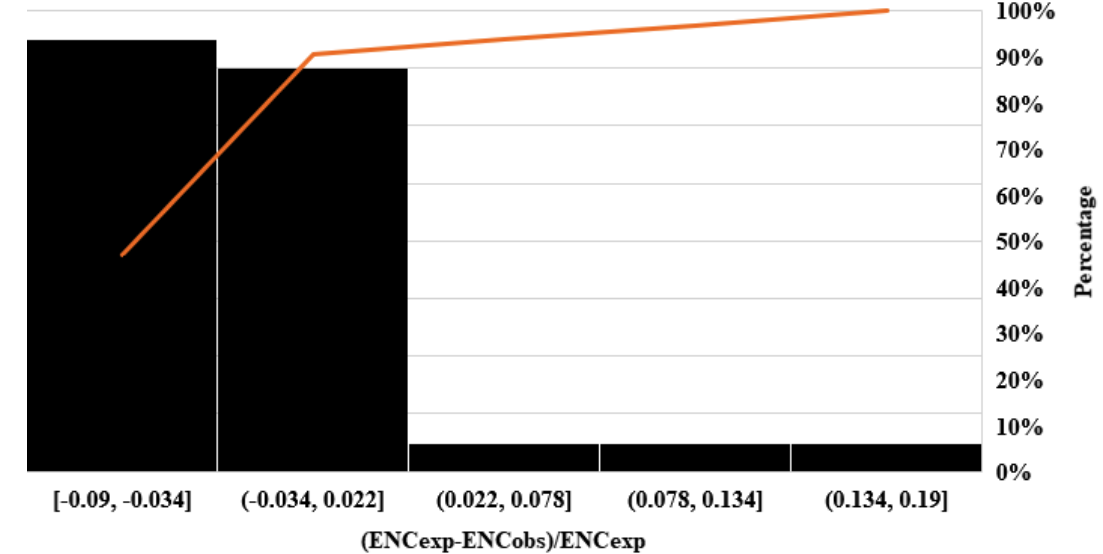
Figure 2. The frequency distribution plot for effective number of codons ratio of observed ENC and expected ENC [ (ENCexp-ENCobs)/ENCexp ].